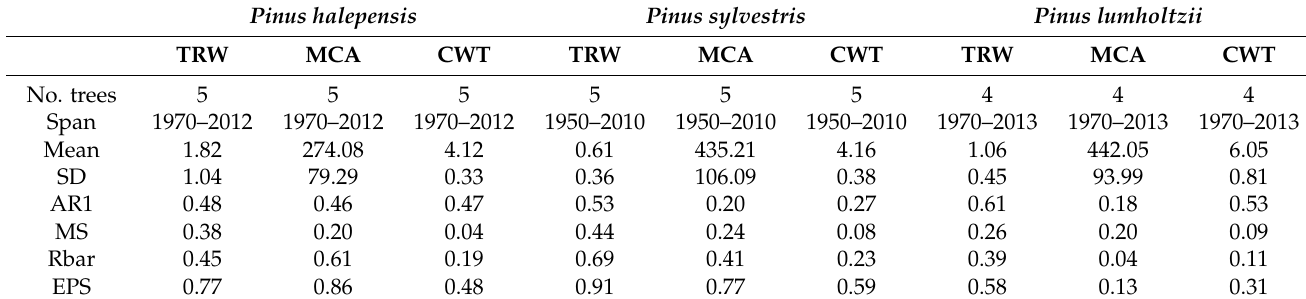
Table 1. Statistical characteristics of raw tree-ring width and xylem trait chronologies (Rbar and mean EPS statistics were calculated from the detrended chronology). SD is the standard deviation; AR1, first-order autocorrelation coefficient calculated from raw data; Rbar is the average inter-series correlation between all series from different trees; EPS is the expressed population signal; MS is the mean sensitivity of the raw time series; variables: TRW, tree-ring width (in mm); MCA, mean conduit area (in µ m 2 ); CWT, cell-wall thickness (in µ m). Pinus halepensis Pinus sylvestris Pinus